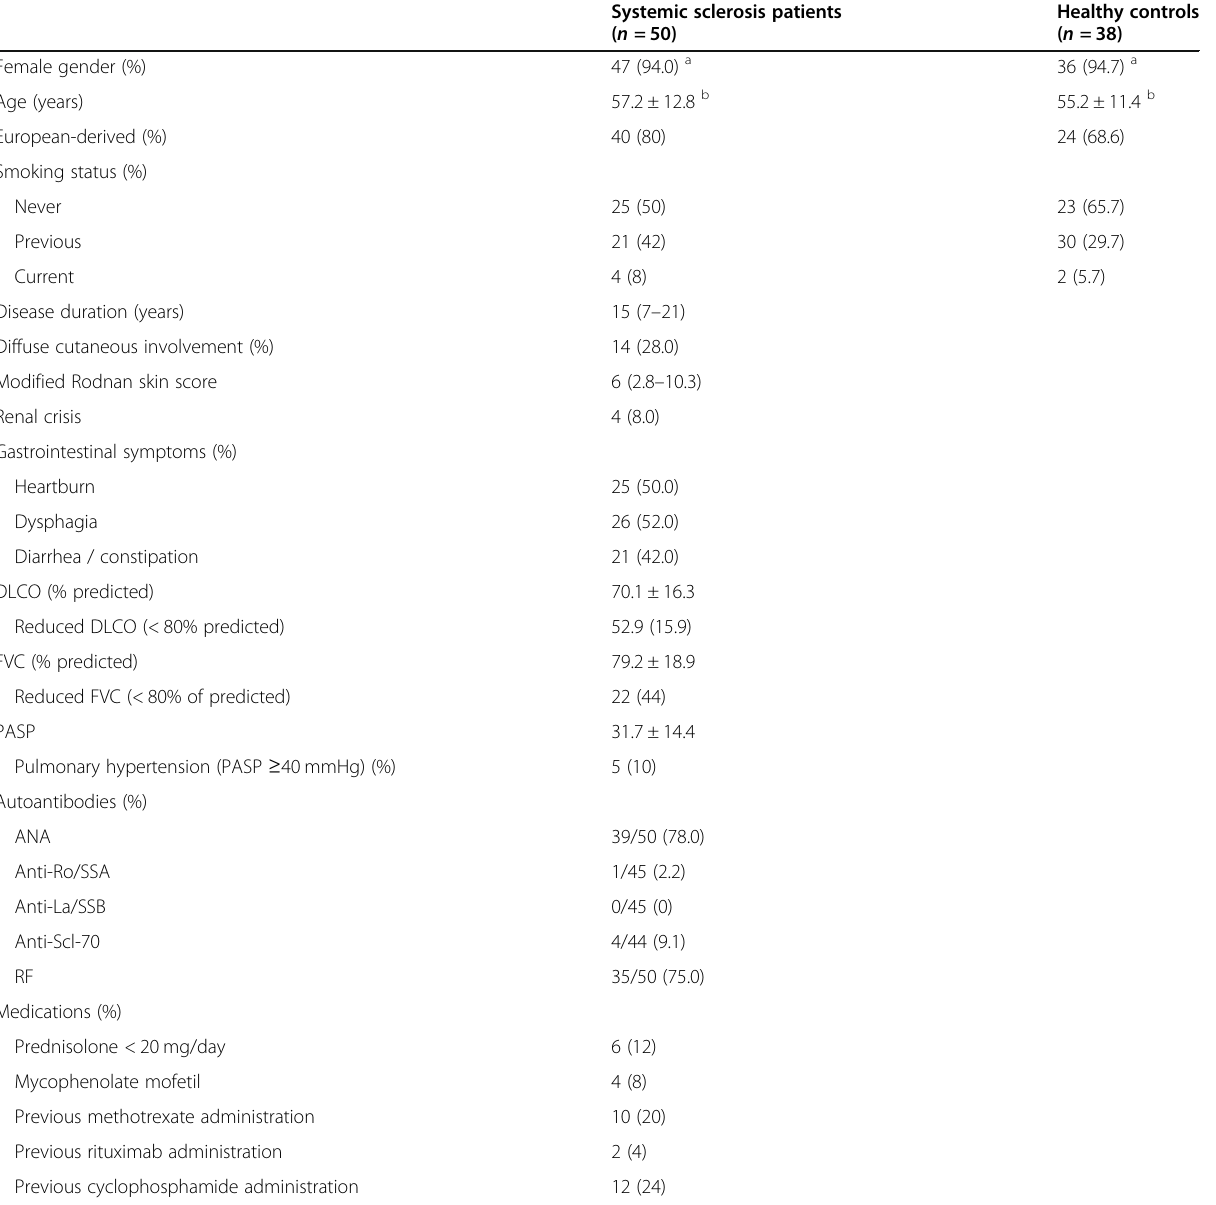
Table 1 Demographic, clinical, and laboratory features of systemic sclerosis patients and controls